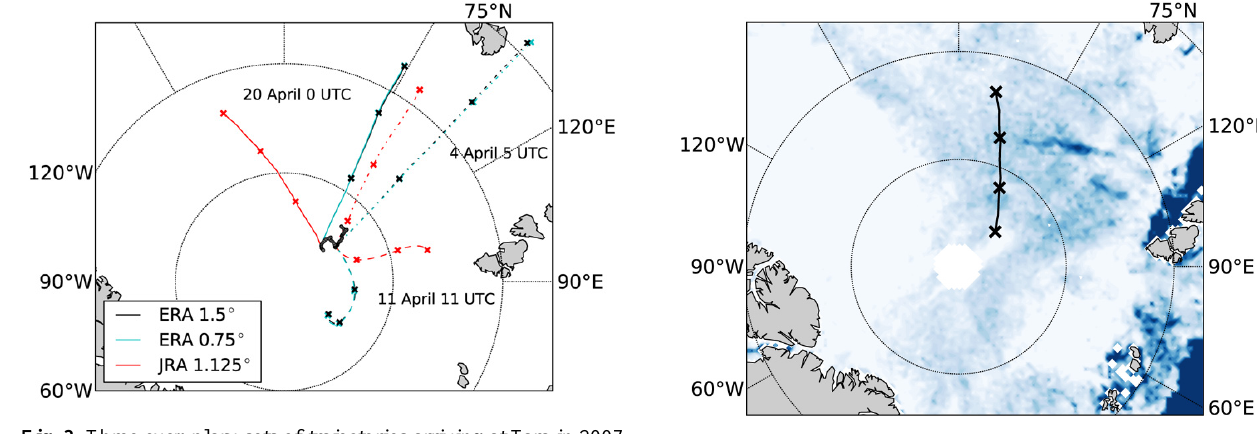
Fig. 3. Three exemplary sets of trajectories arriving at Tara in 2007 calculated using ERA-Interim with two different resolutions and JRA. The temporal differences between crosses are 10h. The pairs of ERA trajectories are nearly overlapping so that the differences between the trajectories of both ERA data sets are invisible. Fig. 4. AA ice concentration on 20 April 2007 and ERA trajectory